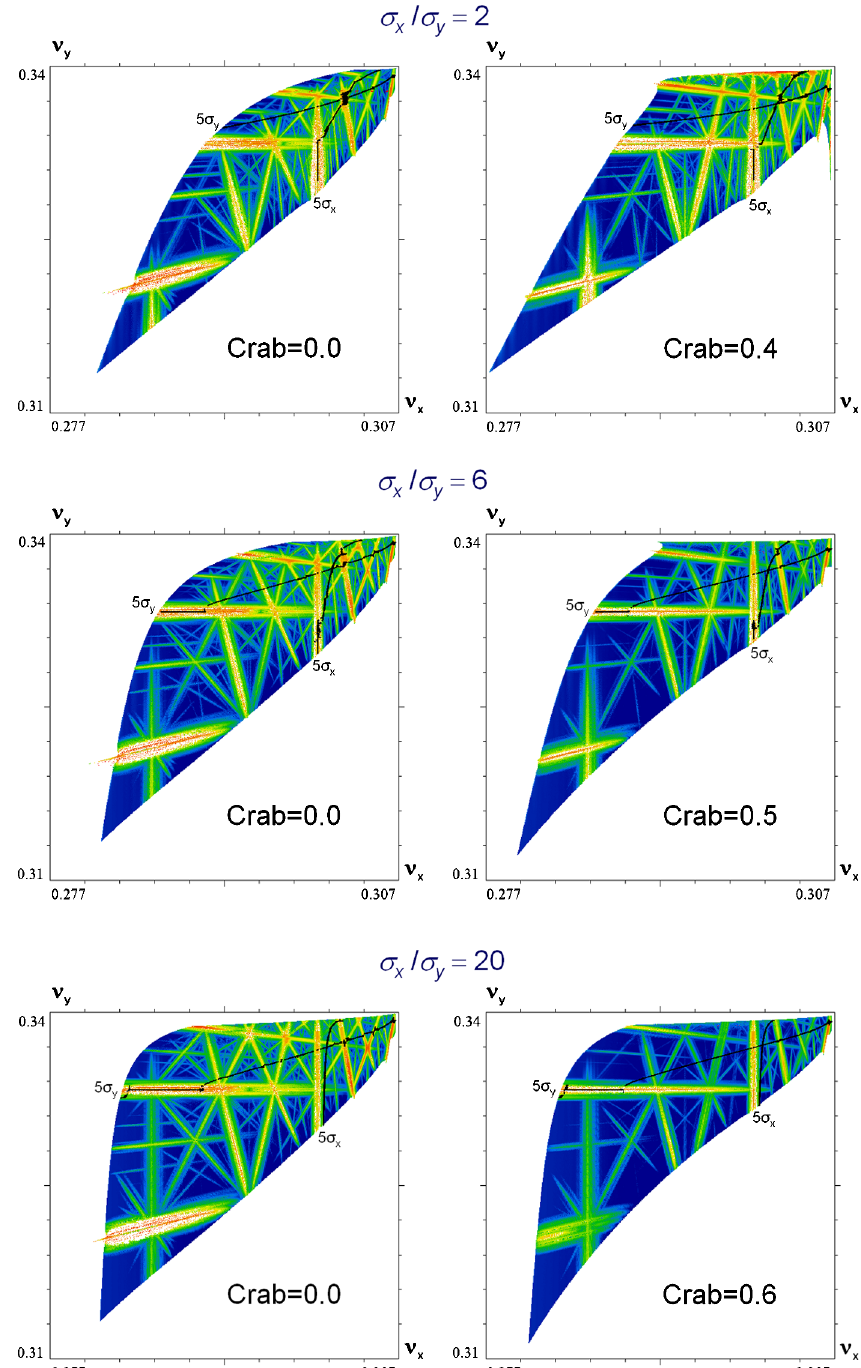
FIG. 14. Efficiency of CW versus the (cid:6) x =(cid:6) y ratio.